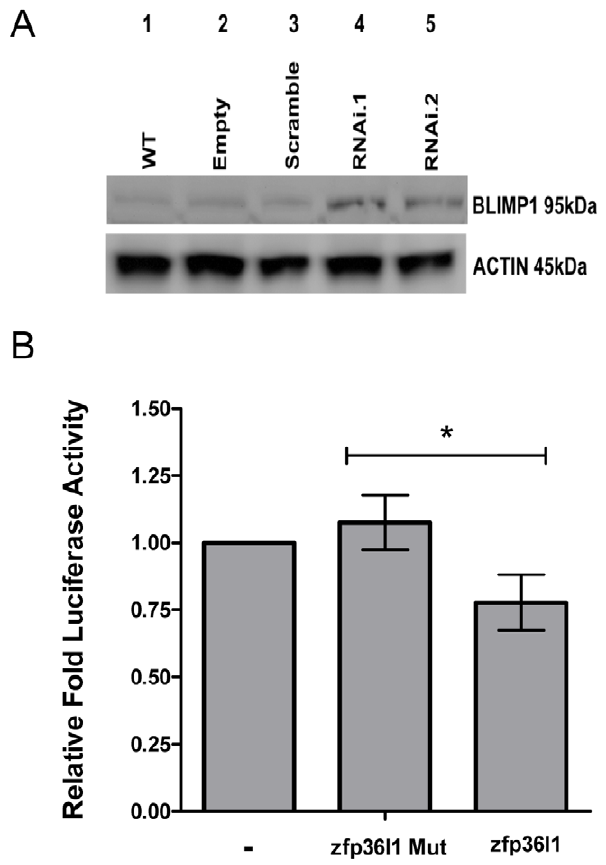
Figure 8. ZFP36L1 knockdown in BCL1 cells is associated with BLIMP1 upregulation and ZFP36L1 interacts with the BLIMP 3 9 UTR. (A) Western blot analysis of BLIMP1 levels in control and ZFP36L1 knockdown cells. BLIMP1 expression levels are upregulated in ZFP36L1 knockdown cells compared to controls. b ACTIN levels are shown as a loading control. (B) ZFP36L1 mediates degradation of the BLIMP1 3 9 UTR. HEK 293 T cells were transfected with pMIRBLIMP1 3 9 UTR construct alone (control) or with either ZFP36L1 or a zinc finger domain mutant, ZFP36L1 Mut. Renilla luciferase was also included in all transfections as a normalization control. 24 hours later cell lysates were harvested and firefly and renilla luciferase levels measured using a Fluorstar Optima plate reader. Relative levels of luciferase activity were measured. Mean 6 SD, are shown for four independent experiments (n=4), *=p , 0.05 as determined by